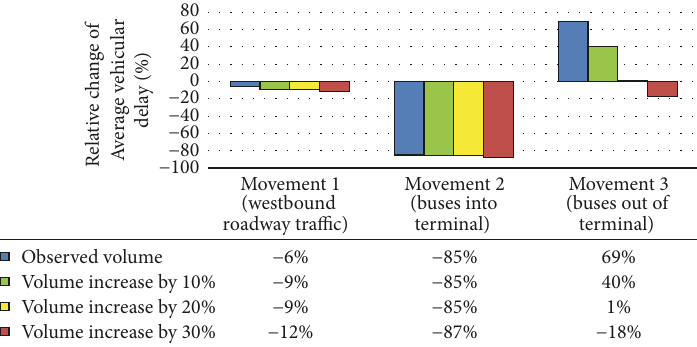
Figure 12: Effects of first alternative design on the average delay (separation median).